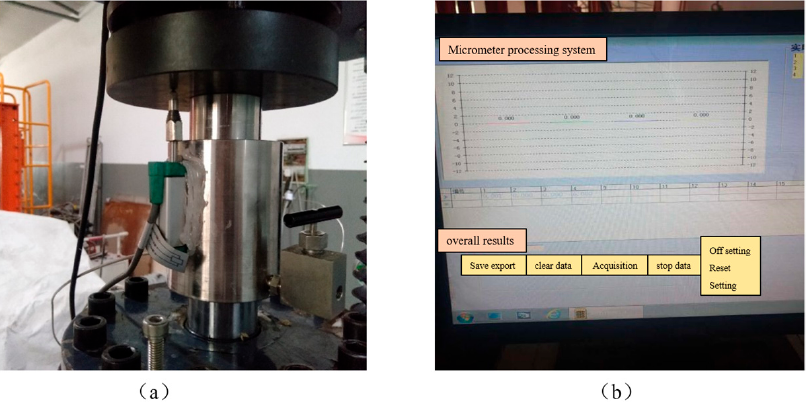
Figure 6. Strain monitoring system ( a ) Place coal sample; ( b ) Strain collection.